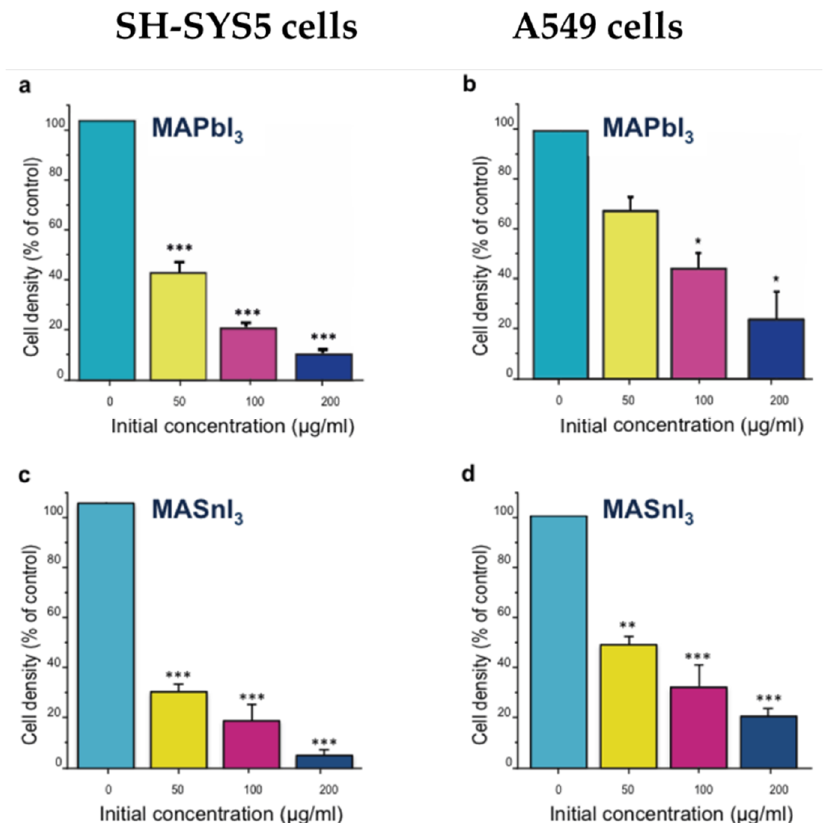
Figure A1. Quantification of living cells upon exposure to MAPbI 3 and MASnI 3 . ( a , c ) SH-SY5Y neuroblastoma cells; ( b , d ) A549 lung epithelial cells. Histograms show the average of triplicate measurements. Bars are means ± σ . The histograms show an average of at least three independent repeats. Bars are means ± σ . One-way ANOVA tests followed by Tukey-Kramer post-hoc tests were performed (non-treated vs. MAPbI3 or vs. MASnI3 treated conditions), * p < 0.01, ** p < 0.005, *** p < 0.0005. Panel b is reproduced from [2] with permission from the Royal Society of Chemistry. Panels ( a–d ) are reproduced from [6] (I.B. doctoral thesis).